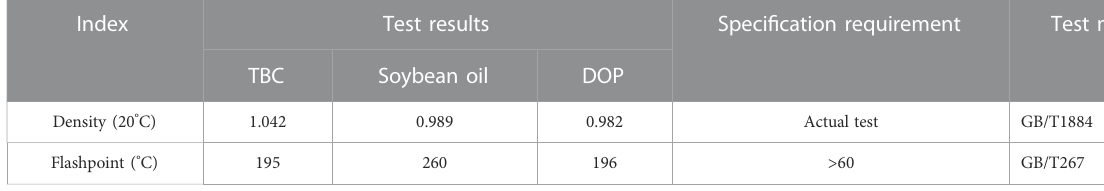
TABLE 3 Plasticizer component.